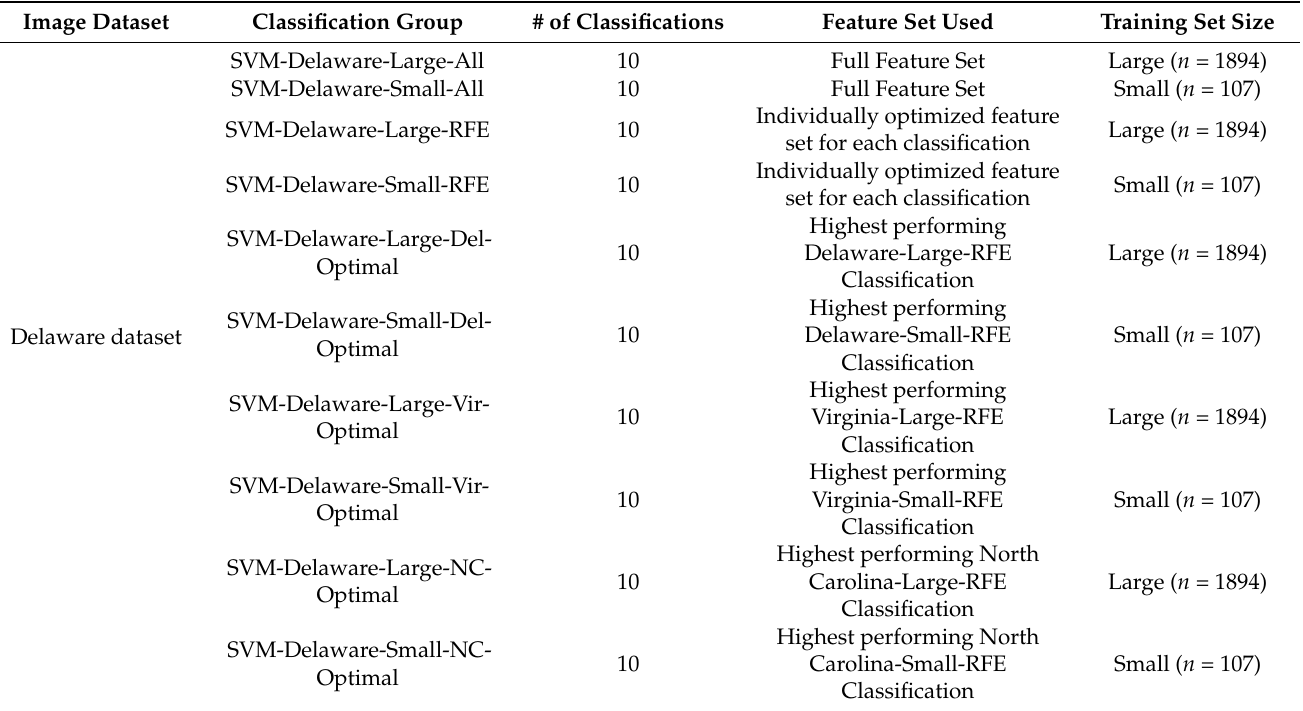
Table 5. Classification groups of the Delaware dataset. Note that the same set of classifications and classification groups were also conducted for the Virginia and North Carolina